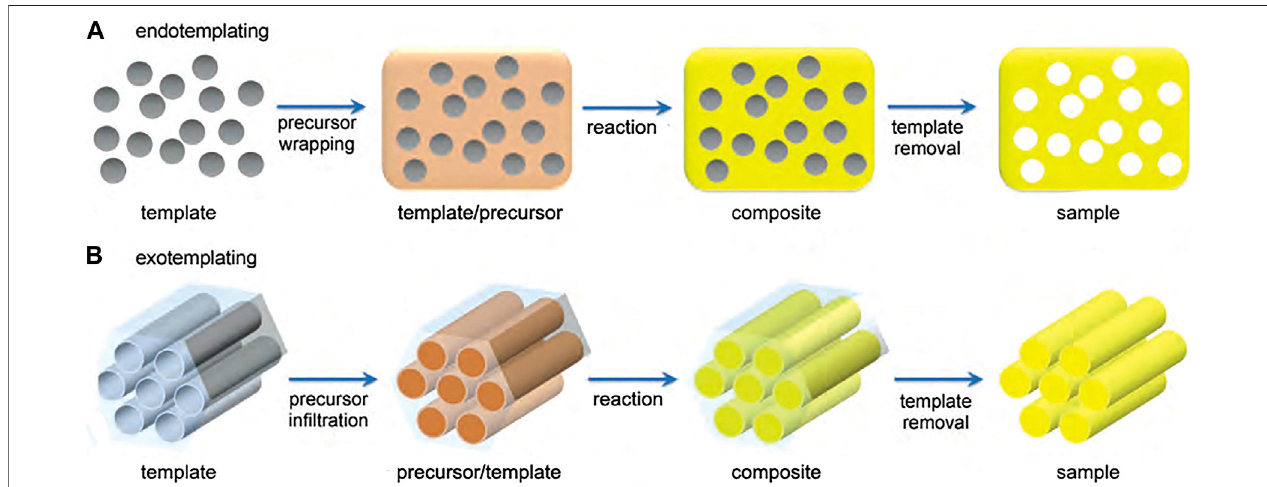
FIGURE 3 | Synthetic mechanism of the hard template method (Wang Y. et al., 2016).